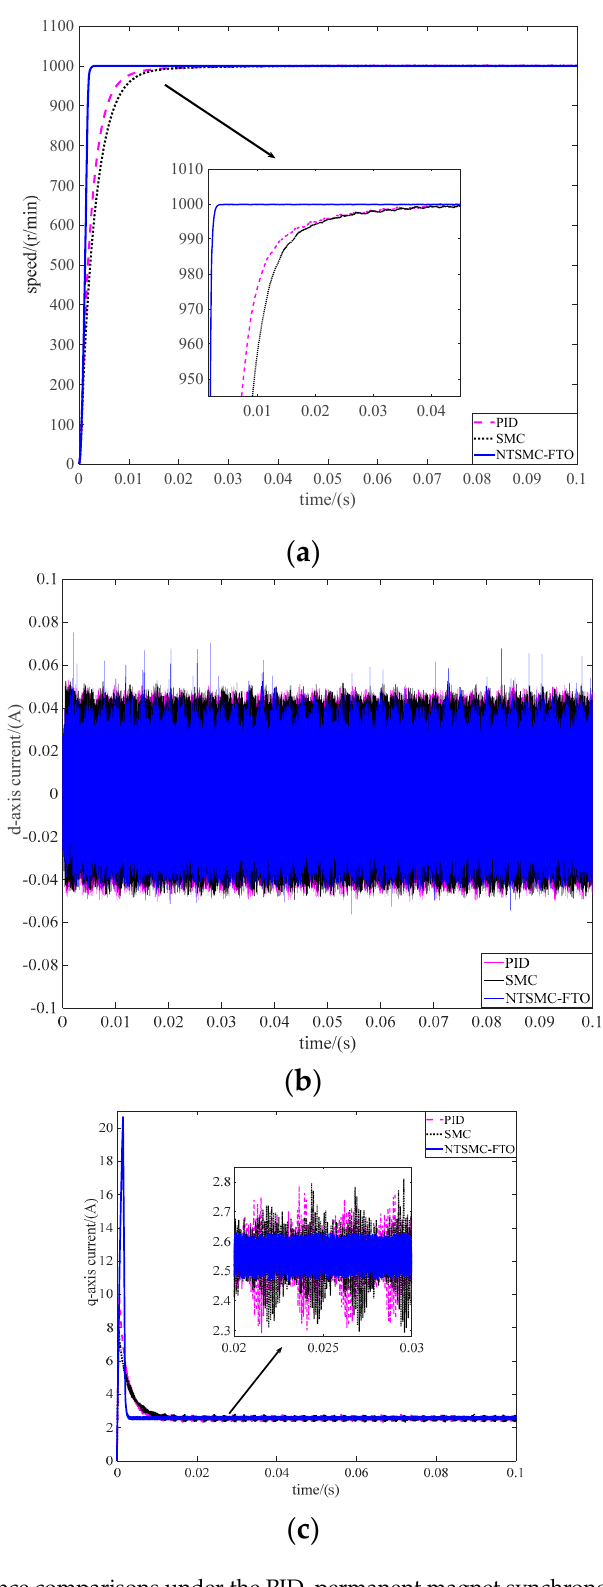
Figure 2. Performance comparisons under the PID, permanent magnet synchronous motor (SMC) and NTSMC-FTO at the phase of startup. ( a ) Speed response curves. ( b ) d- axis current curves. ( c ) q- axis current curves.